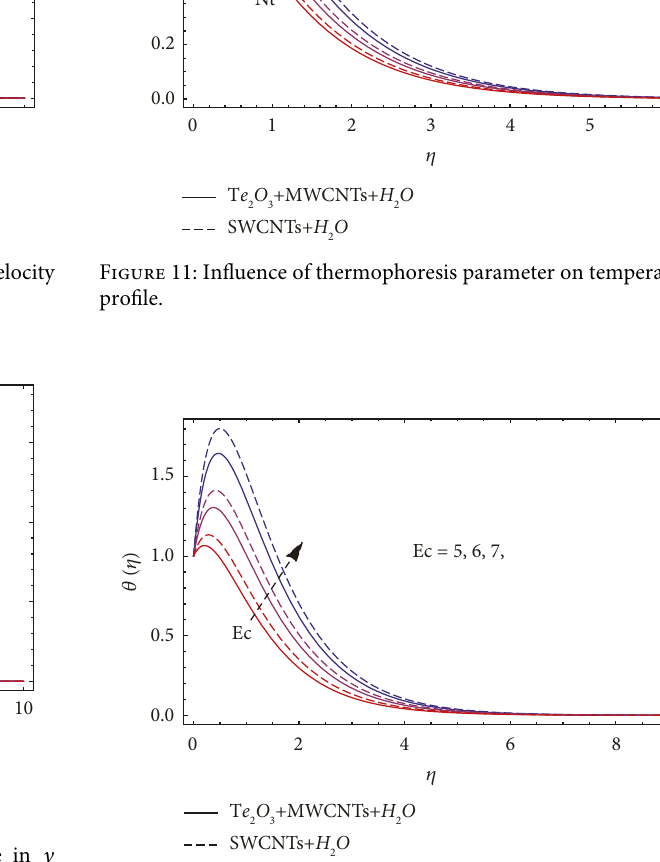
Figure 12: Influence of Eckert number on temperature profile.